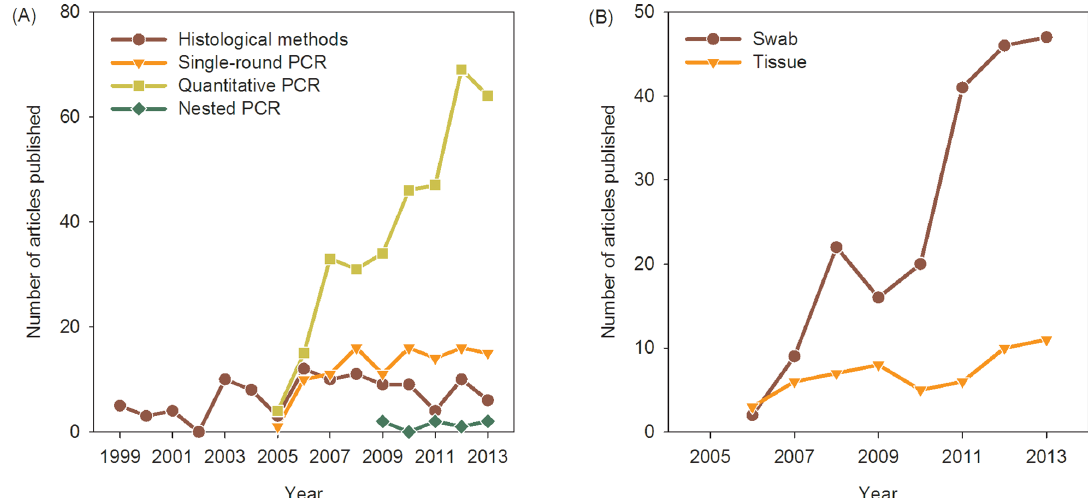
Figure 1. Bd diagnostic methods have changed over time. (A) Initial histological and immunohistological approaches rapidly have given way to PCR methods, especially qPCR. (B) At first, Bd was diagnosed by collecting toe-clips, sloughed skin, and other tissues but assaying Bd infection by swabbing began in 2006 and quickly became the predominant sampling method. Publication data from Science Citation Index, Zoological Record, and Google Scholar.